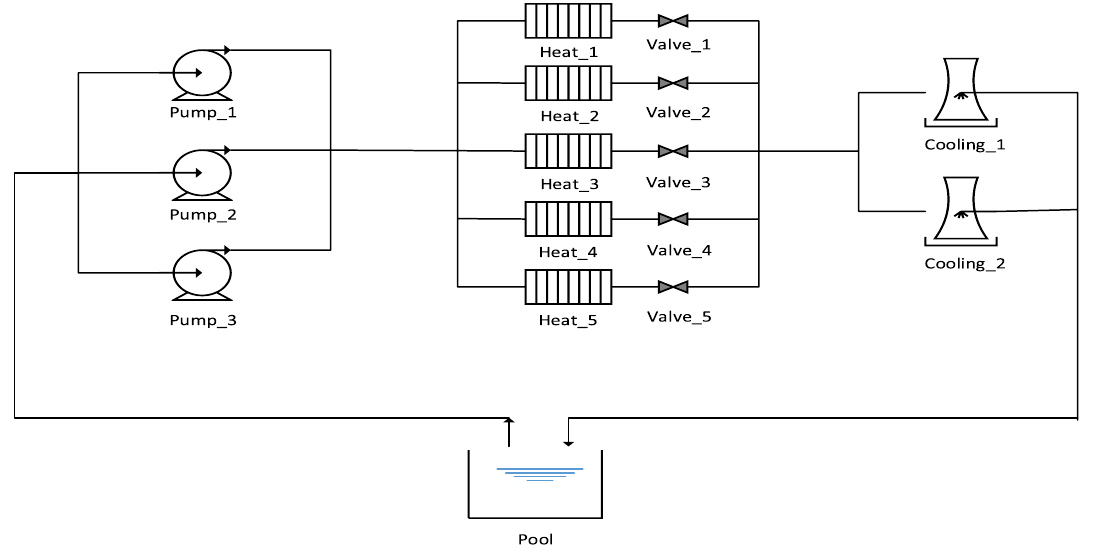
Fig.4 Structure diagram of CCWS of a steel enterprise